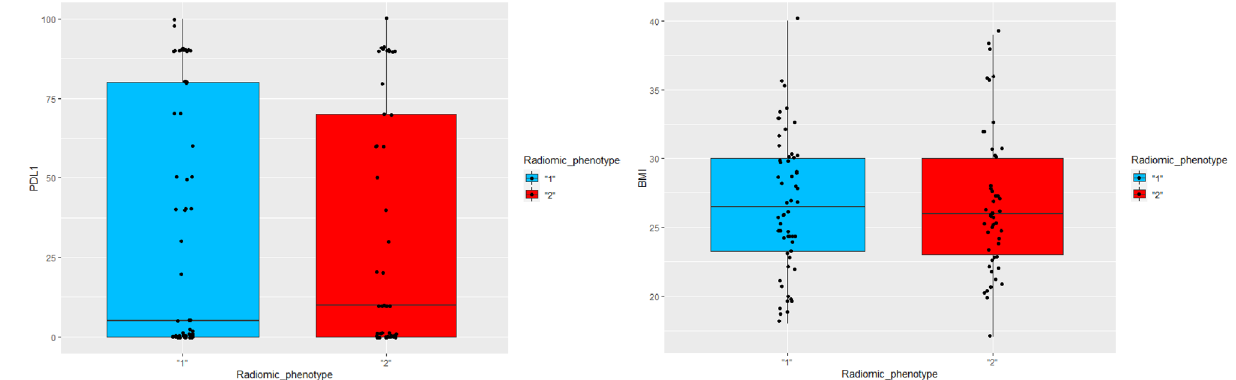
Figure 6. Distribution of PDL1 expression and BMI for radiomic phenotypes 1 and 2. The average value of PDL1 expression for patients belonging to phenotype 1 was 34.5% and those belonging to phenotype 2 was 33%. The average value of BMI for patients belonging to phenotype 1 was 26.7 and those belonging to phenotype 2 was 26.8. The differences in the mean values of PDL1 expression and BMI between patients belonging to phenotype 1 and phenotype 2 are not statistically